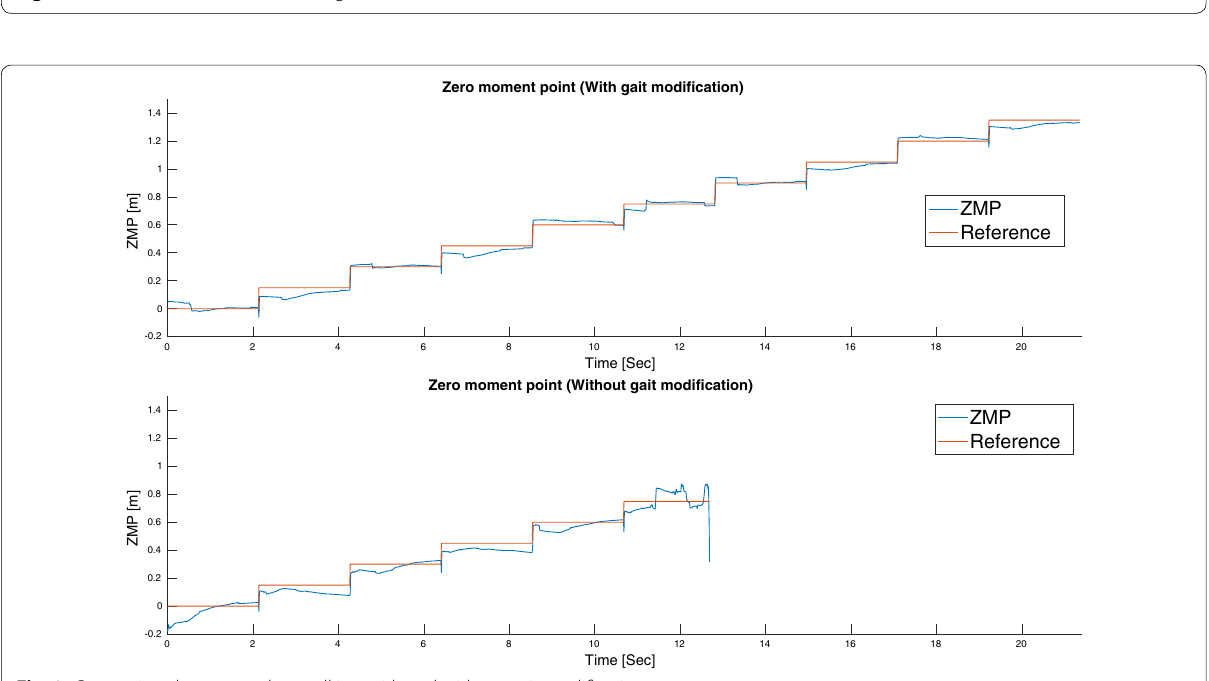
the support polygon while preventing the robot from falling. In the case of walking without gait modifica- tion, the maximum error between ZMP and reference ZMP was 0.434 [m] with an average error of 0.050 [m]. Errors mostly occur when the robot takes a step with no convergence of ZMP to the reference ZMP,